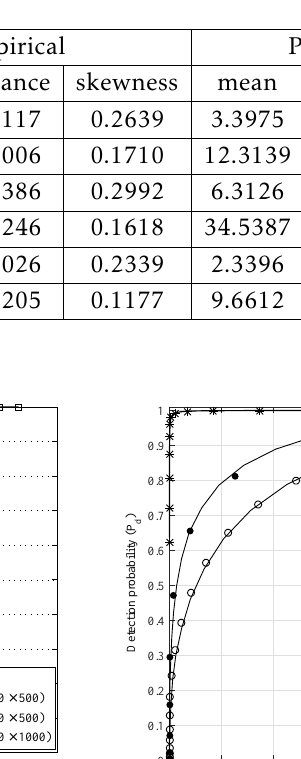
and H hypotheses and it corresponding proposed analytical 0 1